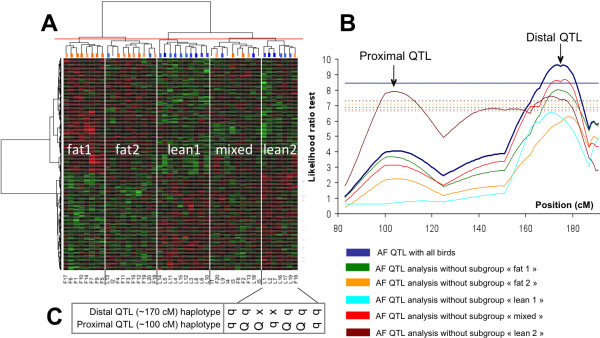
HCA and linkage analysis using subtype combination. (A) Heatmap using the 688 genes (Y axis) and the 45 chickens (X axis). (B) Interval mapping for the AF trait on chromosome 5, with the whole family (blue) and without one subgroup observed by HCA (other colors). The graph gives the statistical test (Likelihood Ratio Test) related to the test "no QTL" versus "one QTL" (y-axis") for every tested location on the chromosome (centiMorgan, x-axis). The chromosome-wide significance threshold at the 5% level obtained for the analysis including all animals (blue) and for analysis without one of the five subgroups: fat1 (green), fat2 (yellow), lean1 (light blue), mixed (red) or lean2 (brown) are displayed. The genetic distances (cM) and likelihood ratio test (LRT) are shown on the X-axis and Y-axis, respectively. (C) The two letters indicate the Q or q haplotype inherited from the sire, with a probability > 99% for the proximal QTL (first letter) or the distal QTL (second letter); × indicates a probability < 99%. The probability of inheriting the paternal Q versus q haplotype was calculated only on the basis of marker information in the region of interest.